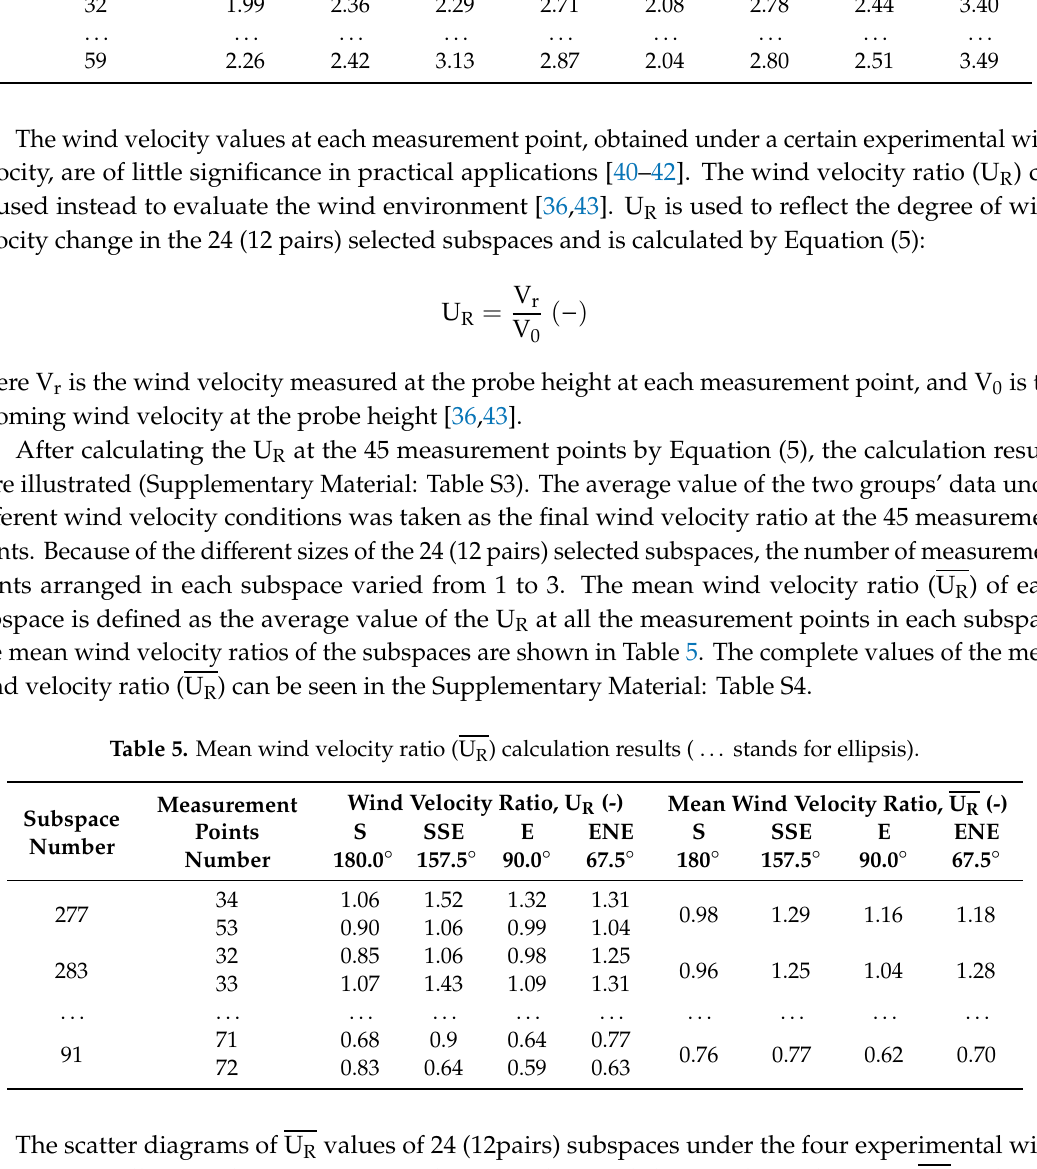
Table 4. Mean wind velocity experimental results (m / s) ( ... stands for ellipsis). Measurement Points Number